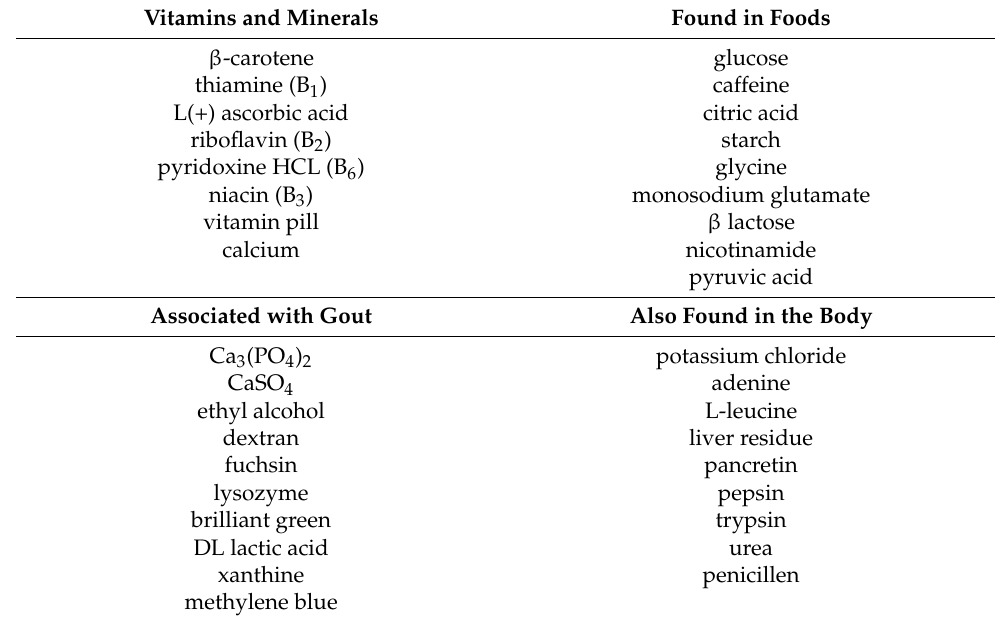
Table 1. Chemical additives used to effect MSU